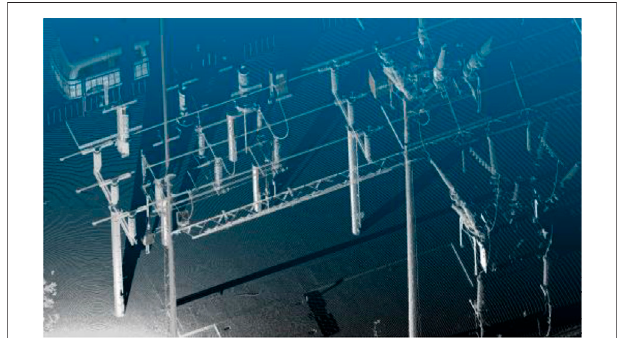
FIGURE 3 | Point cloud of transmission lines.